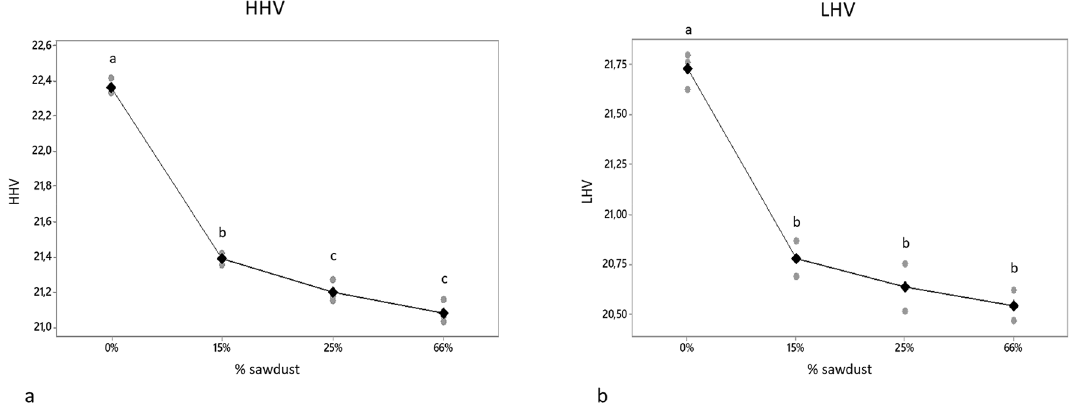
Figure 5. Higher and lower heating value of the pellet. The four types of pellets produced with the percentage of are indicated on the x axis sawdust. The letters indicate a significant difference between the sawdust content at P ≤ 0.05.